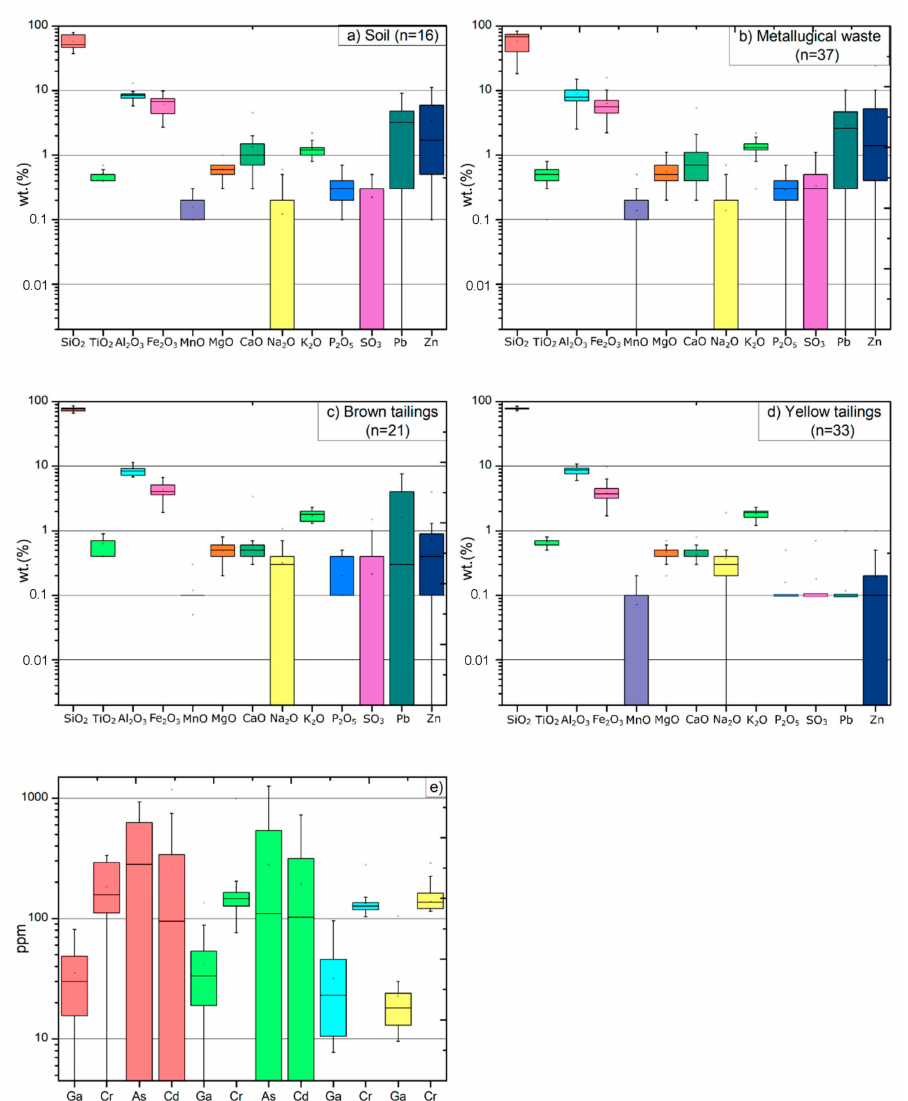
Figure 7. Whisker plots of the elemental concentrations for different anthropogenic units identified at Plombi è res: ( a ) soil, ( b ) metallurgical waste, ( c ) brown tailings, ( d ) yellow tailings, ( e ) values of Ga, Cr, As and Cd in the soil (red), metallurgical waste (green), brown (blue) and yellow (yellow)